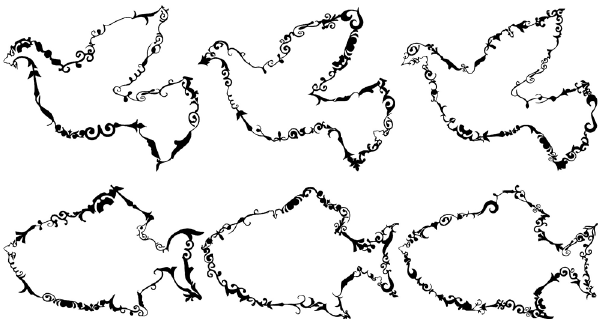
Fig. 10 Left to right: collage results with 25, 35, and 45 patterns (pipe width k =0.08).